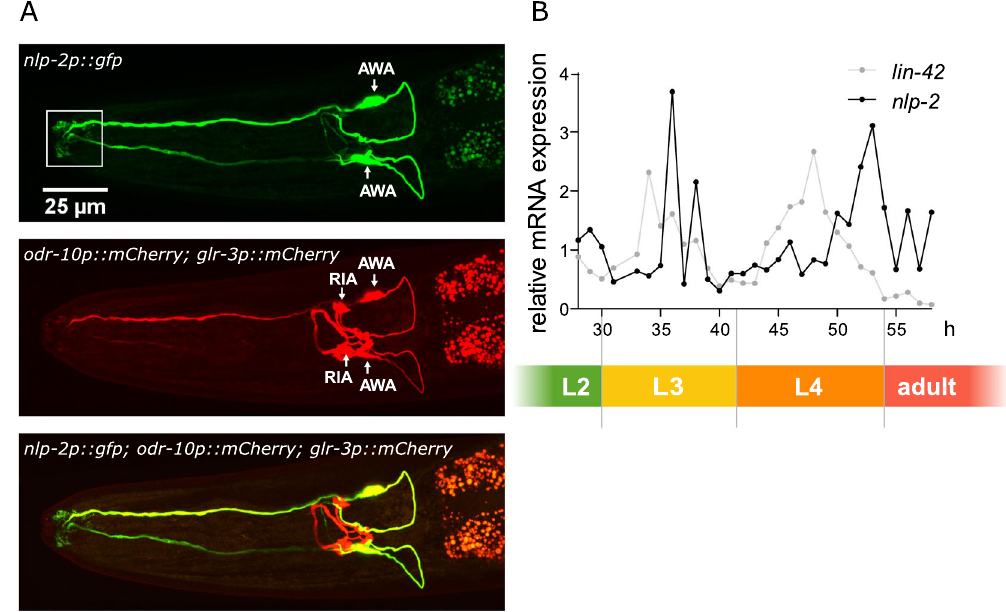
Figure 6. Expression of nlp-2 localizes to AWA neurons and cycles with larval periodicity. ( A ) Expression pattern of a transcriptional nlp-2 reporter transgene [nlp-2p::gfp] in the head region. The upper panel shows the green fluorescent channel displaying [nlp-2p::gfp] transgene expression. The middle panel shows the red fluorescent channel with expression of two marker transgenes: [odr-10p::mCherry] in AWA and [glr- 3p::mCherry] in RIA. The lower panel shows an overlay between the green and red channels, demonstrating that the expression of [nlp-2p::gfp] colocalizes with the AWA marker construct [odr-10p::mCherry] , but not with the [glr-3p::mCherry] . The white box in the upper panel indicates the characteristic cilia at the dendrite tips of the AWA amphid sensory neurons expressing GFP. ( B ) Relative qRT PCR expression of nlp-2 during larval development. The nlp-2 and lin-42 expression levels are plotted during one-hour time intervals of postembryonic development at 20 °C after L1 larval arrest. Larval stage indications are based on the complete temporal lin-42 expression profile (ranging from 0 to 75 hours after